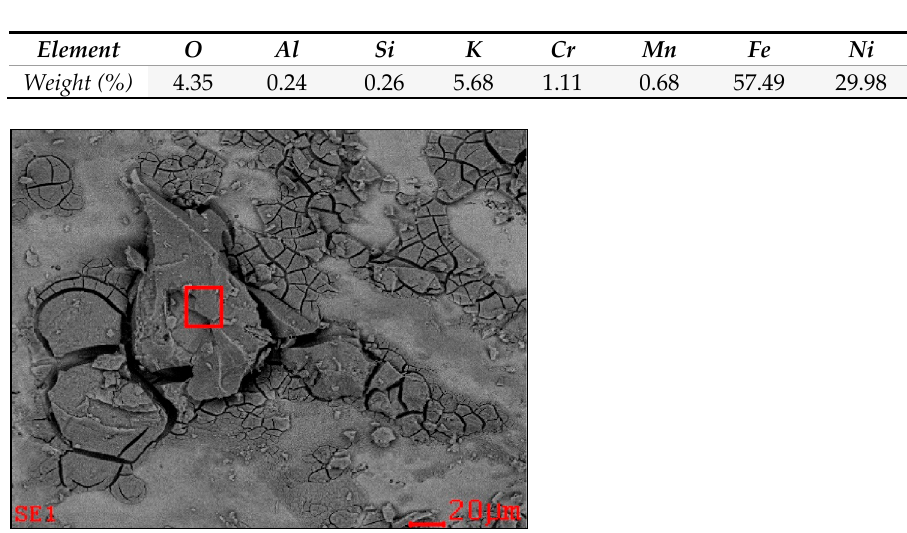
Figure 10. Superficial image magnification of OC4 alloy after 500 h in KOH at 380 °C, including EDX analysis (red square).